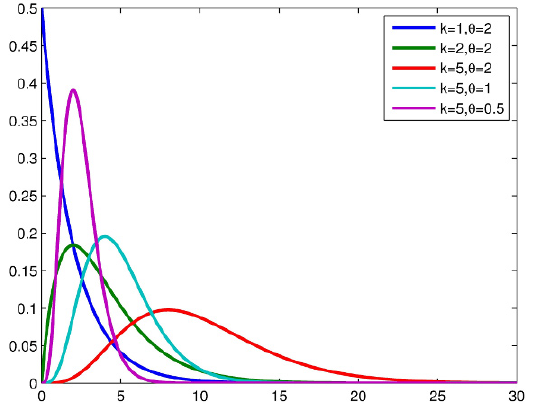
Figure 2. Gamma PDF with different